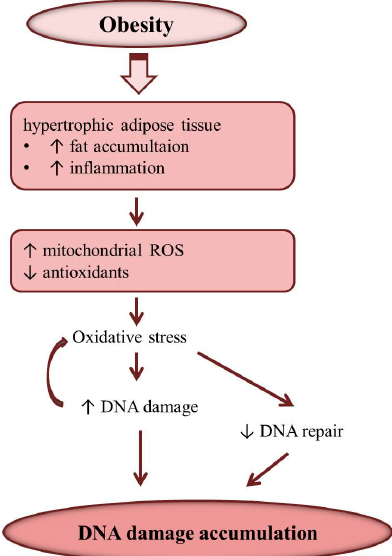
Figure 2. Obesity and DNA damage. Obesity is associated with inflammation and oxidative stress which induces DNA damage and inhibits DNA damage repair resulting in the accumulation of DNA damage in adipocyte and other tissues.